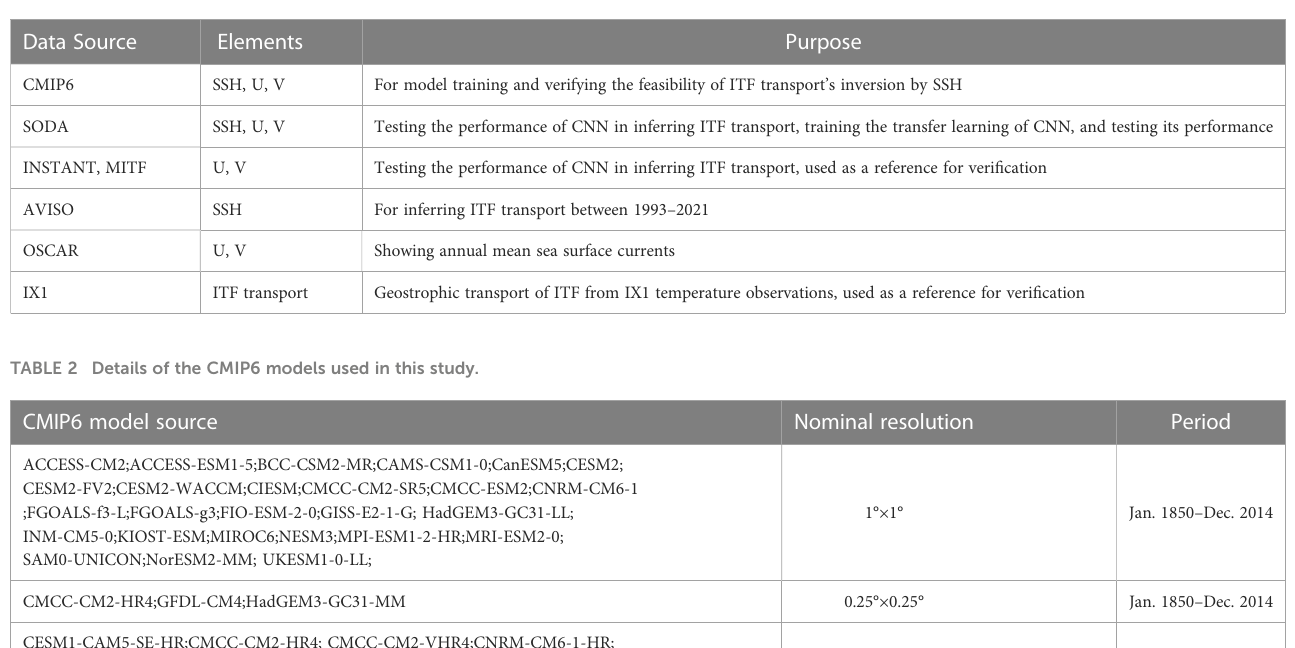
TABLE 1 The speci fi cs of the data used for this study.